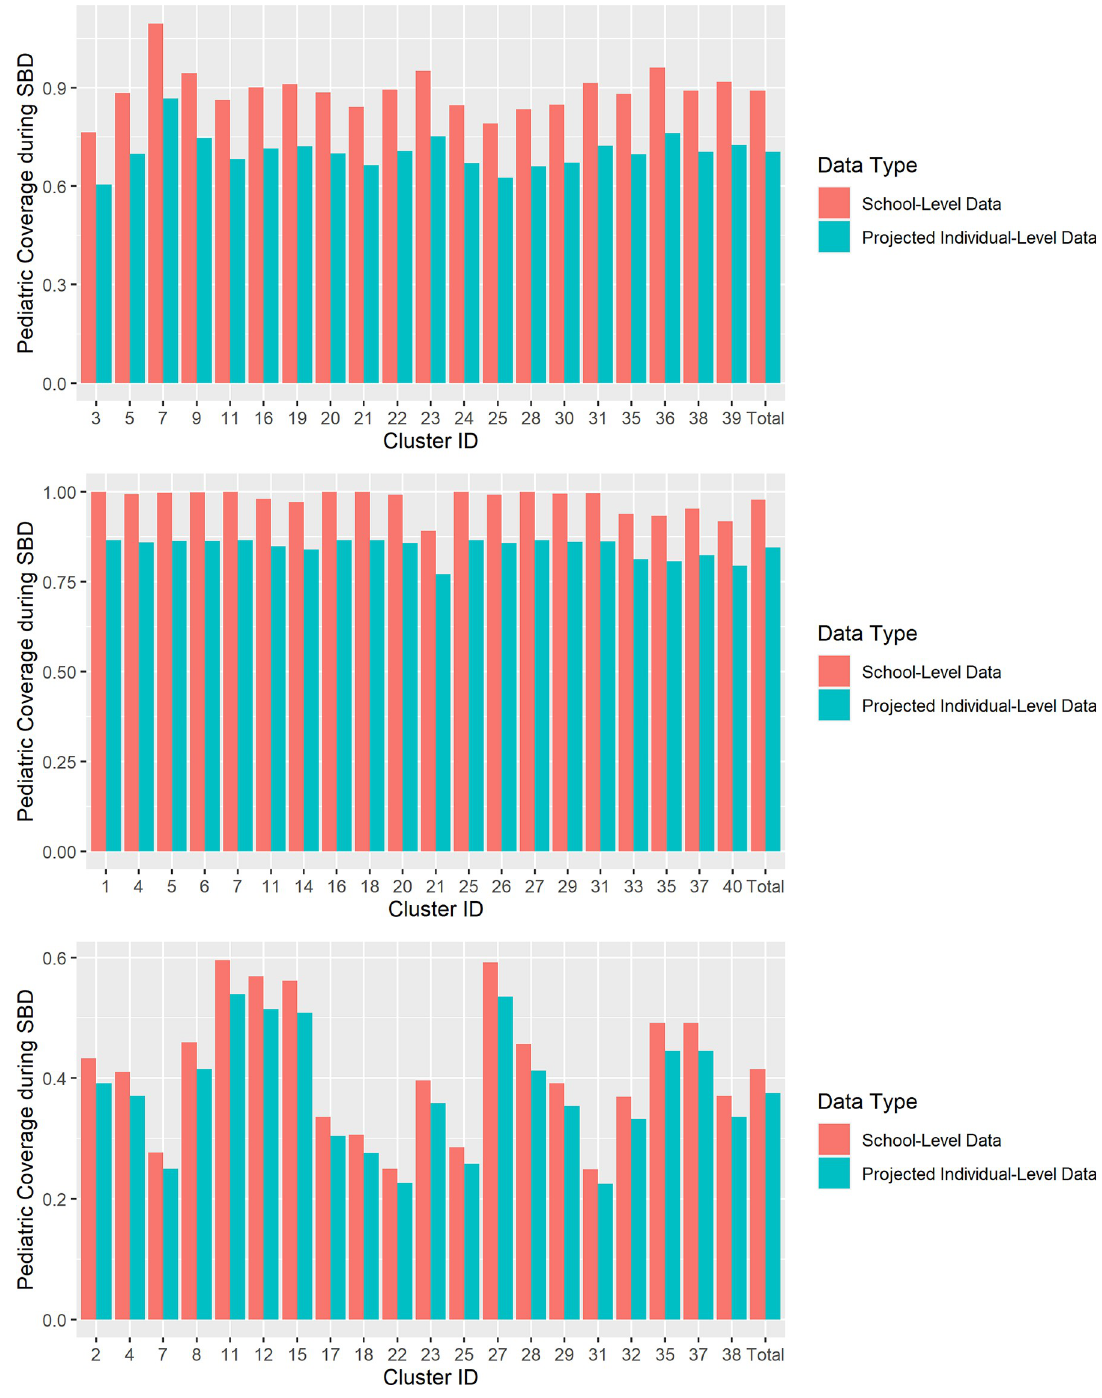
Fig 4. Comparison of school-level SBD coverage estimates to projected SBD coverage estimates in control clusters if individual- level data had been available, by study site. (A) Benin. (B) India. (C) Malawi.